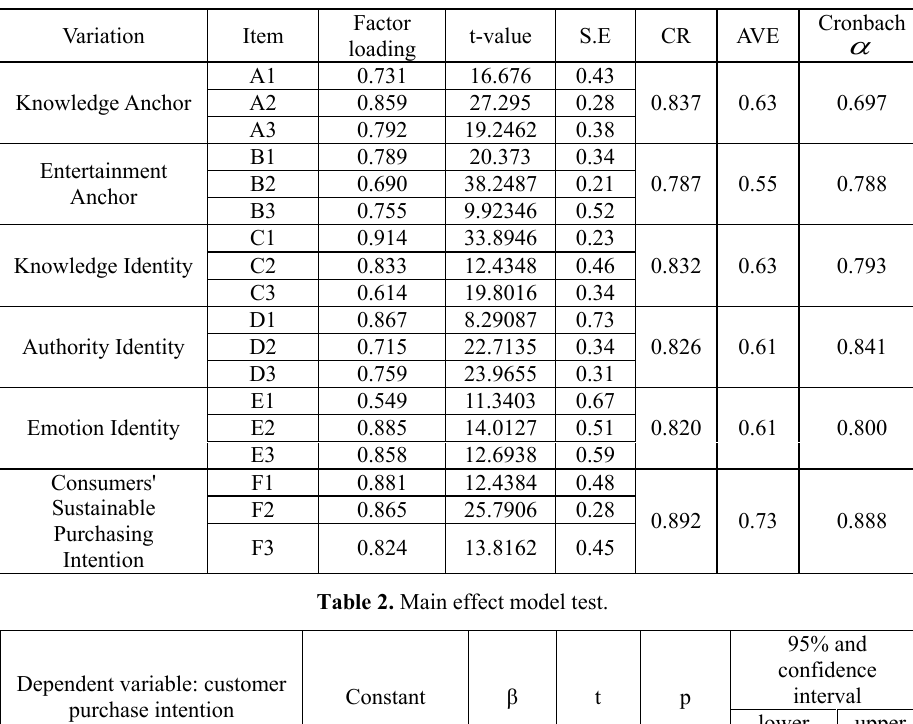
Table 1. Measurement scale.